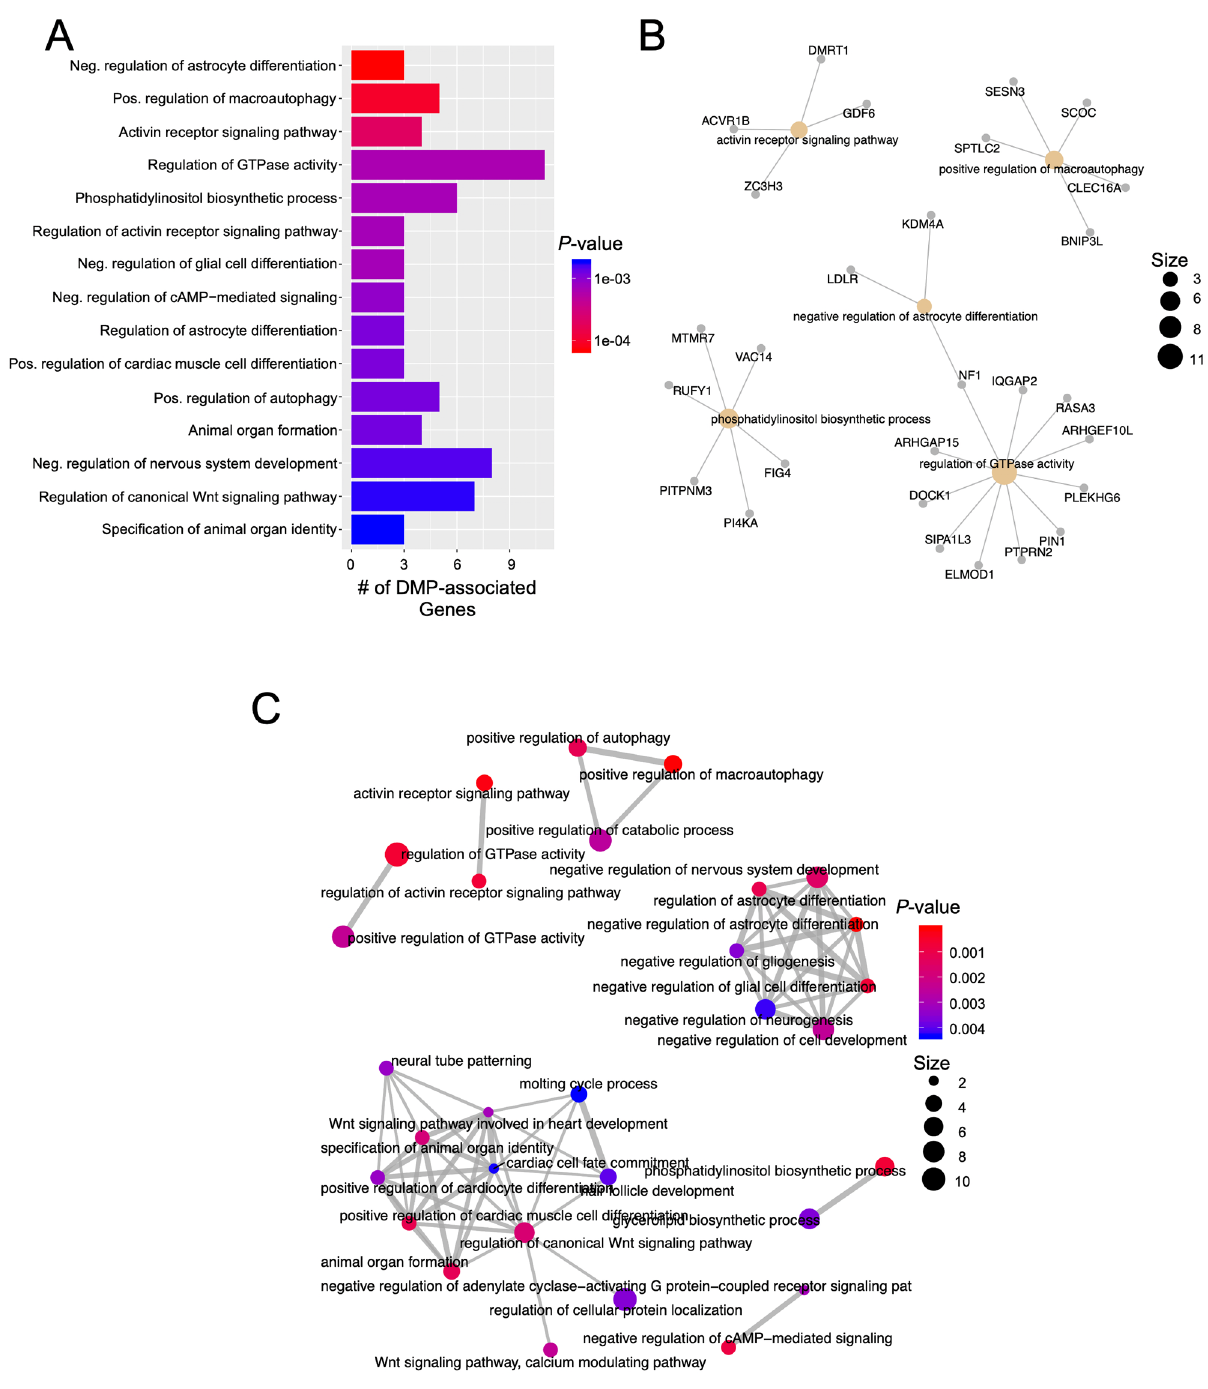
Figure 3. Gene pathways analysis of differentially methylation position (DMP) in CB that were associated infant WM microstructure-related changes (ν IC ) showing a Sex x Symptom interaction. ( A ) Bar Graph of the top 20 gene ontological (GO) biological processes associated with the differentially methylated genes, ordered by statistical significance. X-axis indicates the number of DMP-associated genes contributing to each GO term. The shade of the bars shows the p value based on the legend, as determined by a Fischer test. Neg. = Negative; Pos. = Positive. ( B ) Gene-concept network plot shows the top five gene ontology terms (beige), the genes (gray) associated with each term, and the interconnectivity between genes and processes (lines). The size of the beige dot relates to the number of DMP-associated genes contributing to that term. ( C ) An enrichment map plot depicts the connectivity of associated terms, with hubs of similar processes clustering further apart. Node (spheres) size represent the relative number of DMP-associated genes contributing to each term, while the color represents the FDR p -value, shown in the legend, as determined by a Fischer test. The size of the edges (gray lines) depicts the strength of relatedness between terms. Bar graph, gene-concept network plot, and enrichment map were constructed using the R environment 44